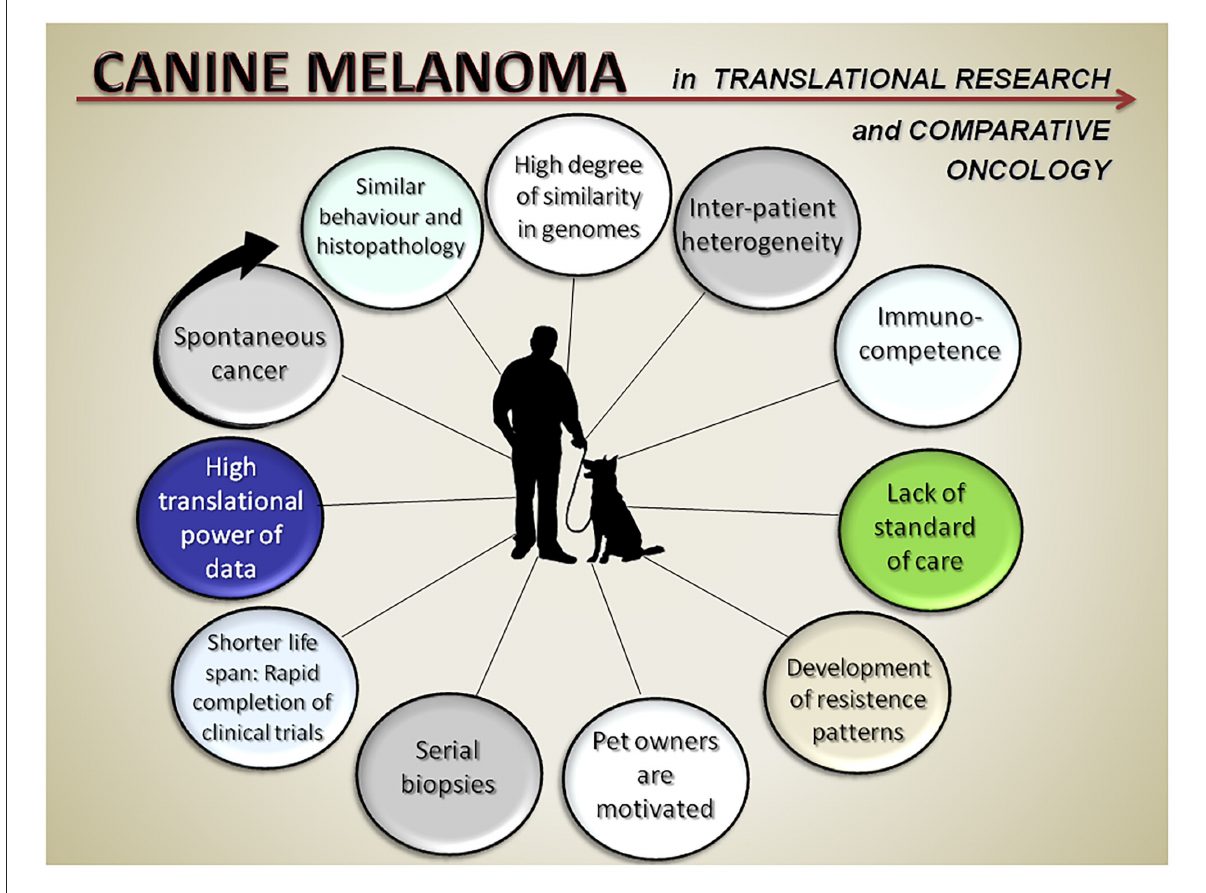
FIGURE1 Points of strengths of the canine melanoma spontaneous model in translational research and comparative